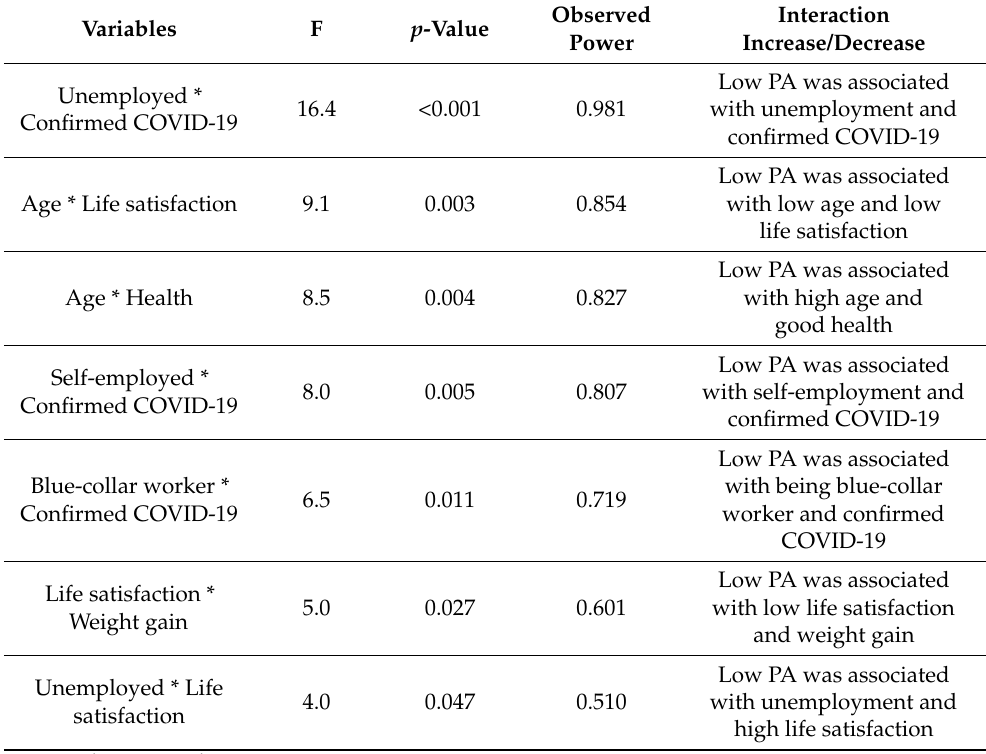
Table 3. Interaction model for